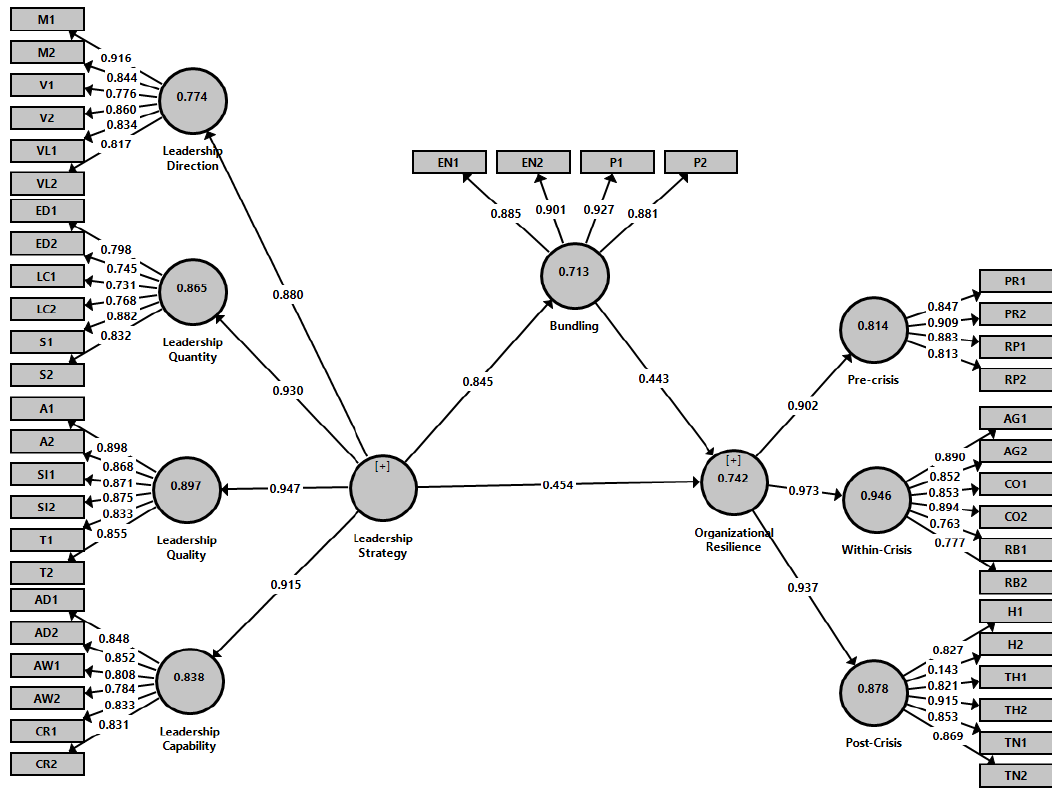
Figure 5 : Mode t-Statistics of Resource Structuring